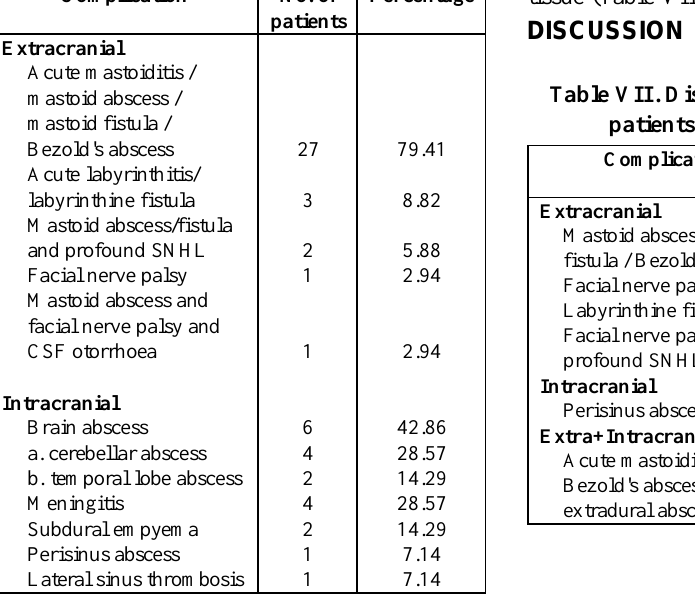
Table VI. Distribution of complications in cholesteatomatous cases